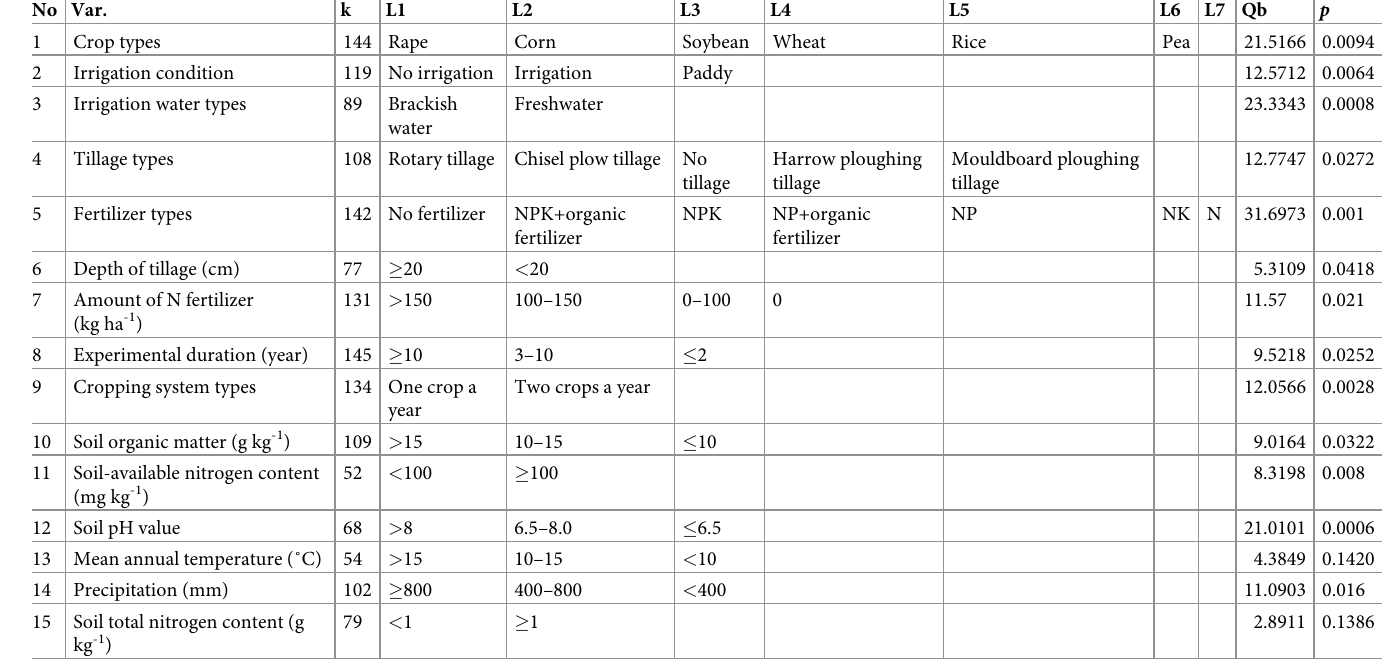
Table 1. Categorical variables ( Var ), total number of paired observations of crop yield for crop residue return and no-straw treatments (k), specific levels of each Var (L), between-group heterogeneity (Qb), and significant P values produced by the meta-analysis. No